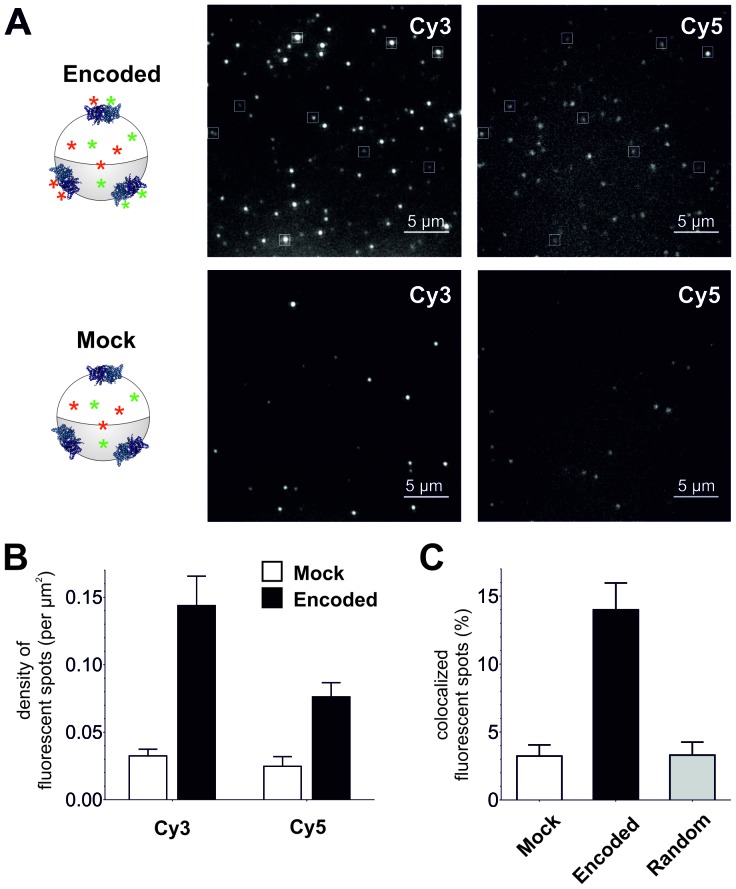
Single-molecule TIRF microscopy imaging of cellular encoded Cy3 and Cy5 fluorophores in ClC-0, a dimeric plasma membrane chloride channel.(A) TIRF images show distinct fluorescent spots for Cy3 and Cy5 encoded into ClC-0 at position E166 (Encoded (top), Mock (bottom)). A subpopulation of Cy3 and Cy5 spots colocalized (highlighted in white boxes). The encoded and mock injected images were grayscaled to identical levels to enable viewing of both bright and dim spots. (B) Number density of fluorescent spots per area (µm2) of plasma membrane was significantly different between Encoded (black) and Mock (white). p values see main text. Total numbers of counted spots included in this analysis are: N = 4406 for encoded Cy3, N = 2459 for encoded Cy5, N = 1154 for mock Cy3, N = 717 for mock Cy5; they result from ≥5 oocytes (≥3 batches) per condition (C) Same images as in (B) were examined for colocalization between Cy3 and Cy5. In Encoded, 14 ± 2% of the Cy5 signal merged with Cy3. Random colocalization in those images was estimated to 3 ± 1% and colocalization in Mock was not significantly different from that (p=0.96). All values are mean ± s.e.m.